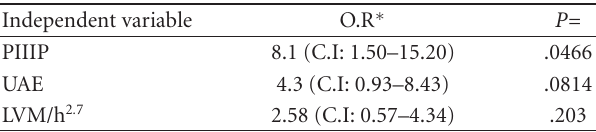
Table 5: Logistic regression analysis. Deviance (likelihood ratio) chi- square = 14,281753 df = 3 P = .